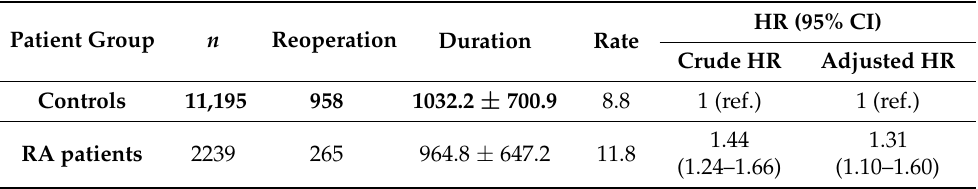
Table 2. Crude and adjusted hazard ratios for reoperation in rheumatoid arthritis (RA) patients compared with the control group.